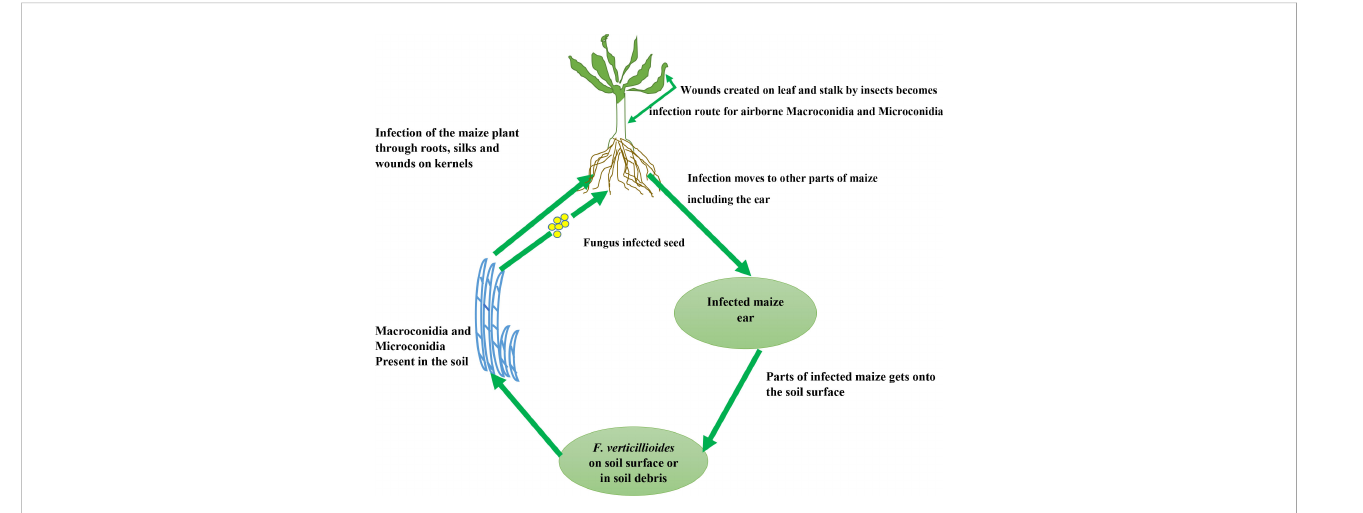
FIGURE 2 Infection cycle of F. verticillioides in